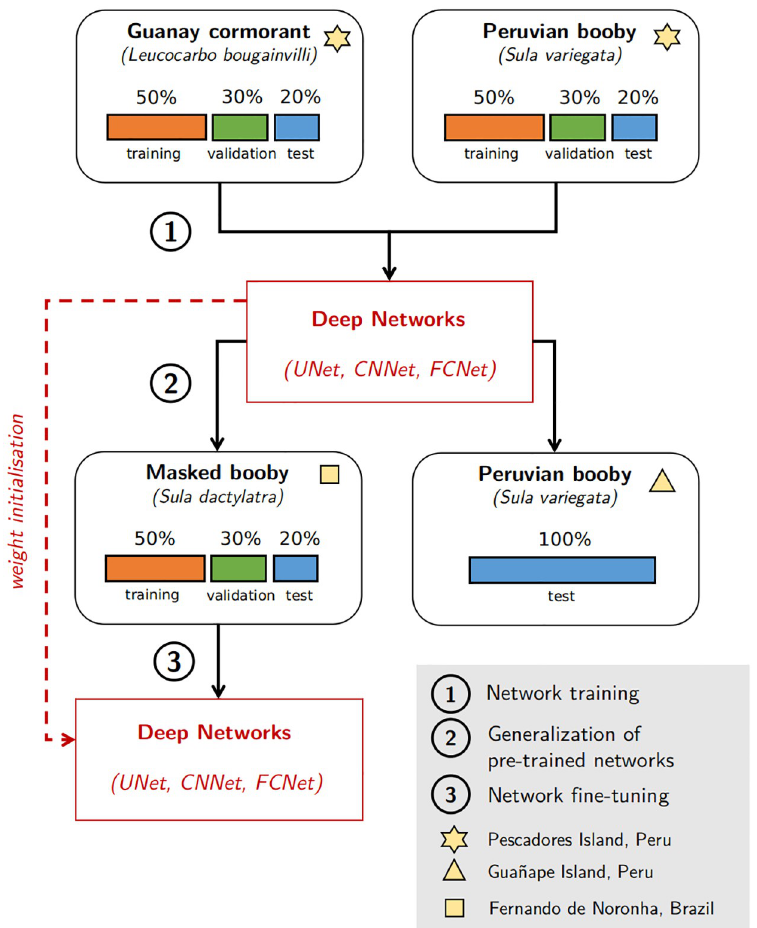
Fig 2. Evaluation scheme. (1) The datasets from Pescadores Island (see Table 1) have been used to train, validate and test deep networks. UNet, CNNet and FCNet refer to the deep network architectures used in this study (see Fig 1). (2) The trained networks have been directly used to predict dives on two other datasets without any additional training (Datasets from Gua ñ ape Island and Fernando de Noronha). (3) The dataset from Brazil have been used to train, validate and test deep networks. However, the deep networks previously obtained at step (1) have been used for weight initialization. This is known as Fine-tuning.